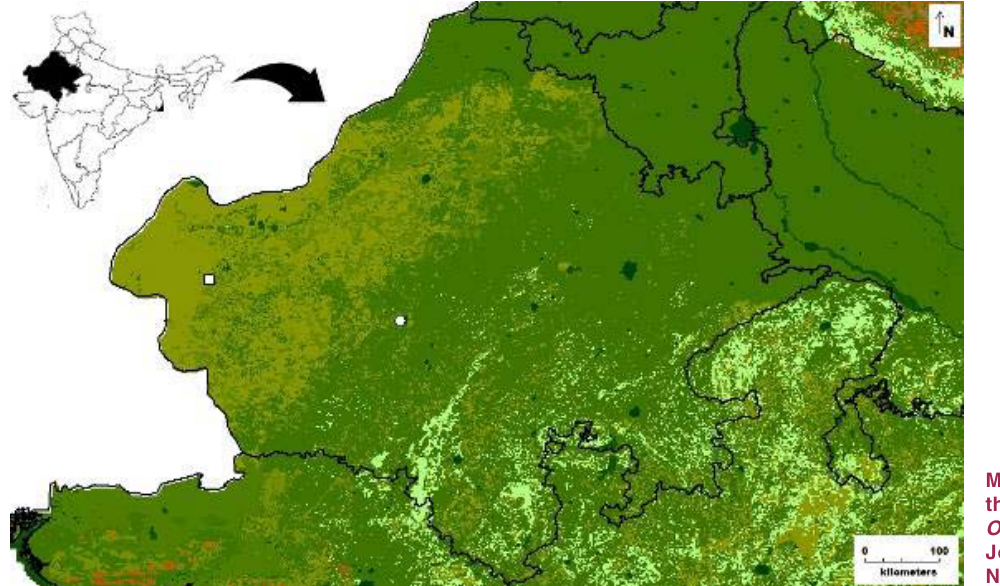
Table 1. Morphometrics of male Orthochirus krishnai recorded with a vernier caliper (+ 0.01 mm) Character Orthochirus krishnai ( BNHS-Sc-13 ) ( in mm ) Carapace length 4 Carapace anterior width